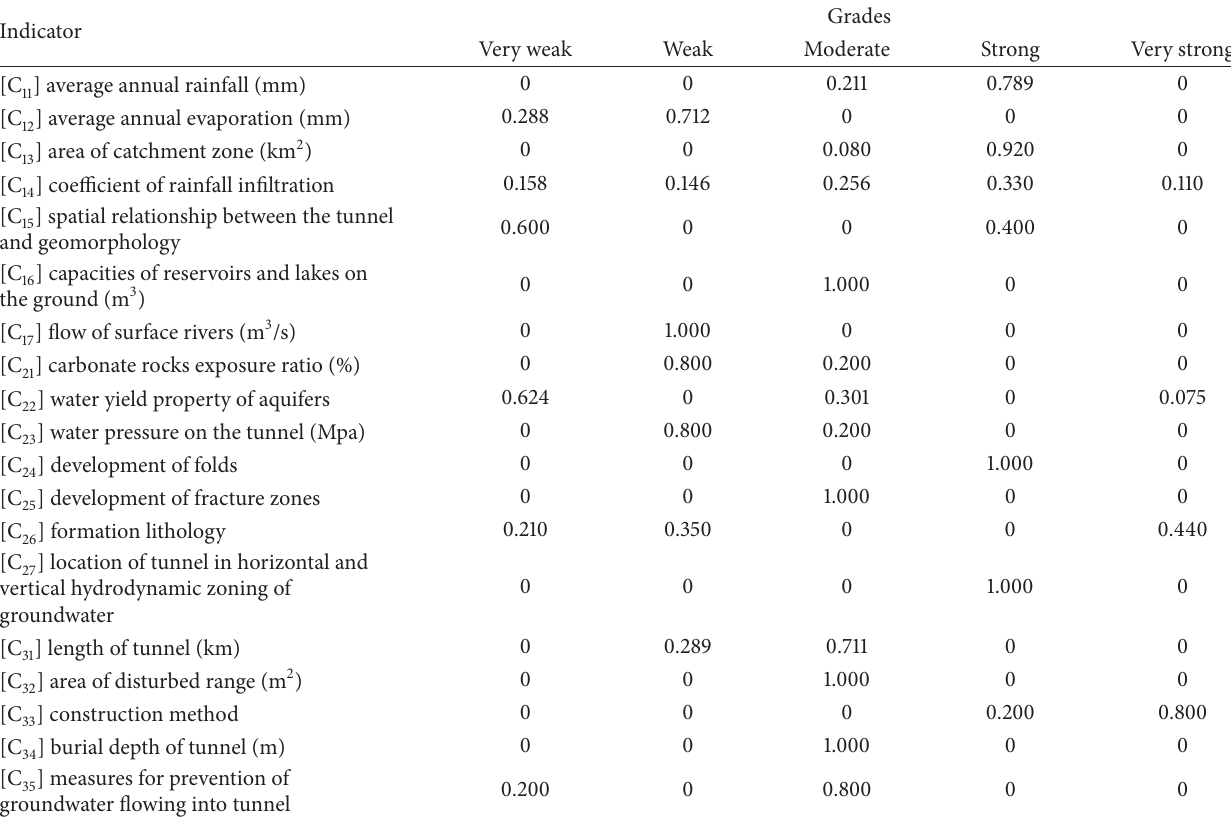
Table 5: Membership of each indictor at every level calculated from quantification of Tongluoshan tunnel and the evaluation criteria.